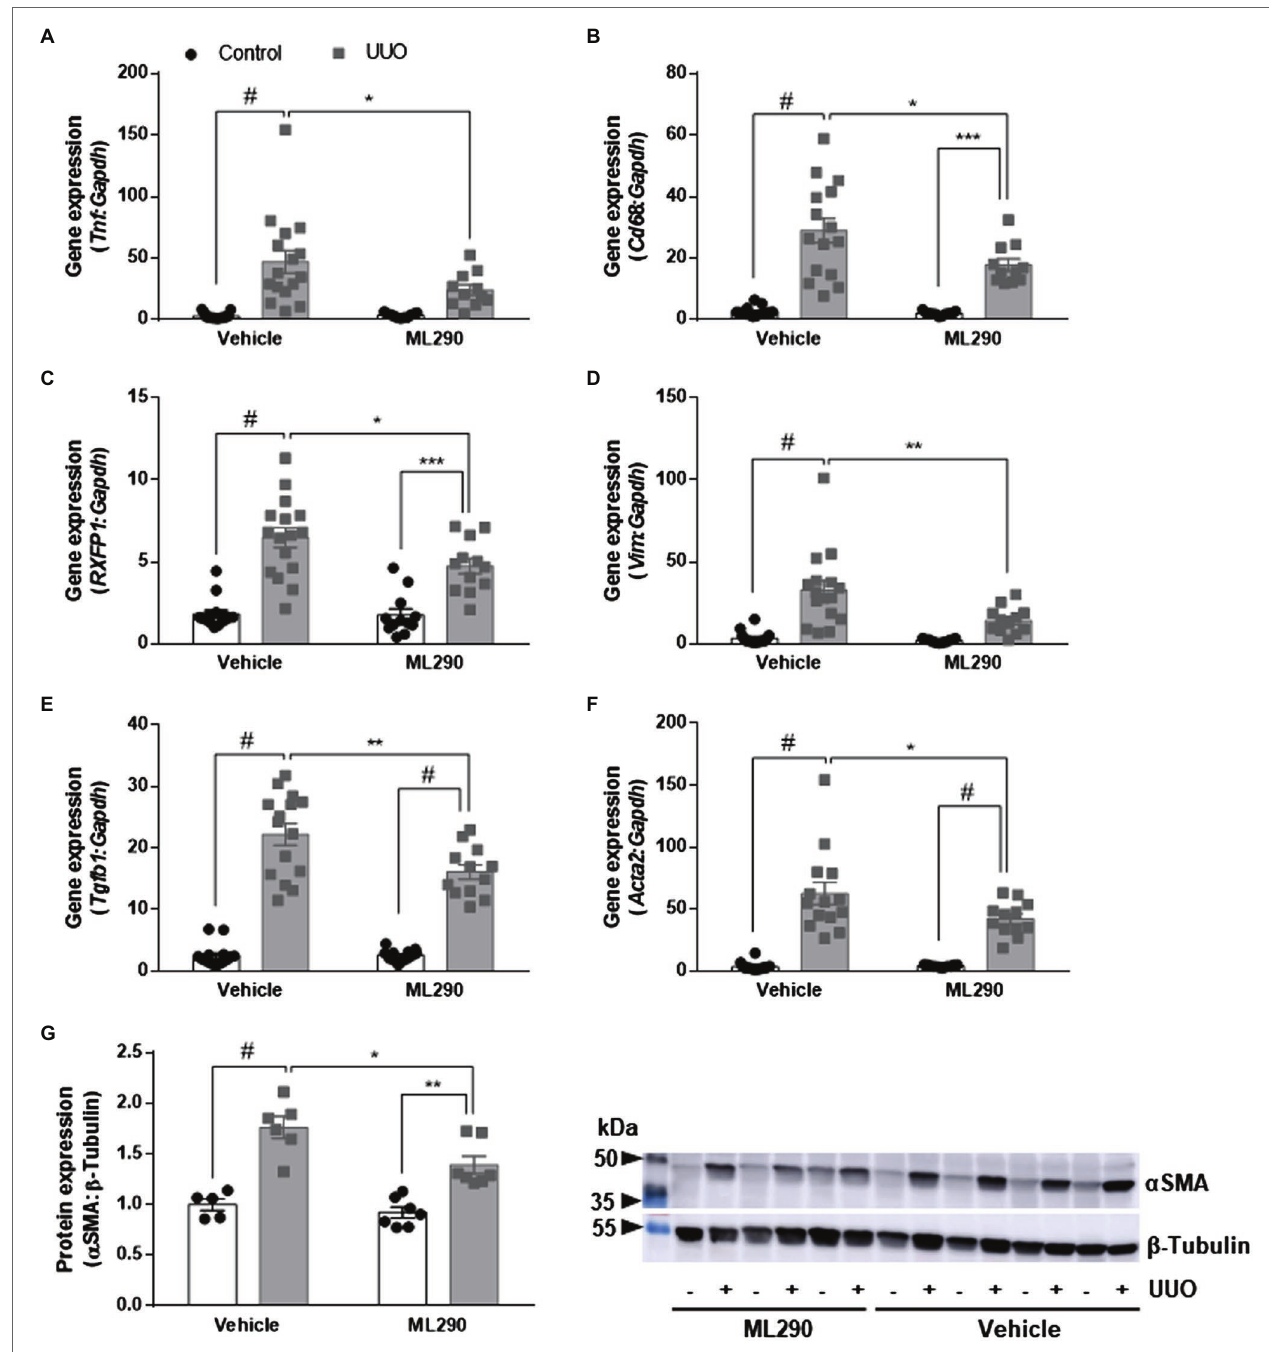
FIGURE 3 | (A–F) : Tnf (A) , Cd68 (B) , RXFP1 (C) , Vim (D) , Tgfb1 (E) , and Acta2 (F) gene expression in the control and UUO kidneys from vehicle- and ML290- treated humanized mice ( n = 12–16 mice/group). Gene expression is normalized to the housekeeping gene Gapdh and presented as fold change to control kidneys from vehicle-treated mice. (G) : Densitometry of α SMA (42 kDa) protein expression in the control and UUO kidneys from vehicle- and ML290-treated humanized mice ( n = 5–7 mice/group). β -tubulin (55 kDa) was used as the loading control. * p < 0.05, ** p < 0.01, and # p <